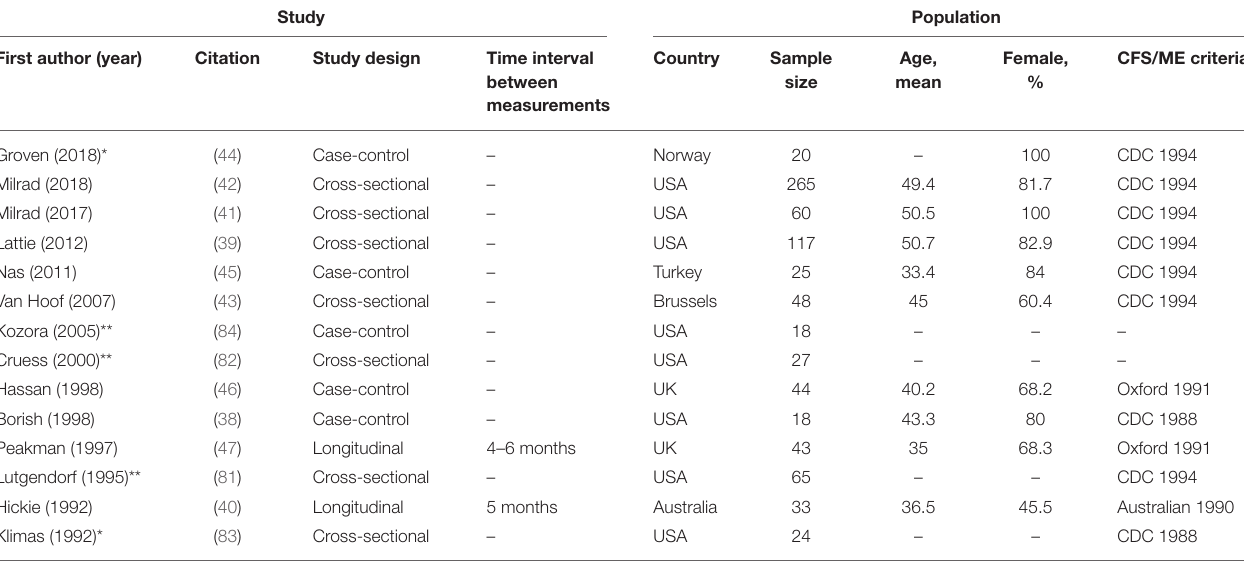
TABLE 1 | Key characteristics of the included studies, including first author and year of publication, citation, study design, time interval between measurements (longitudinal studies only), country in which the study was conducted, sample size, mean age, percentage of females, and the criteria used for CFS/ME diagnosis.